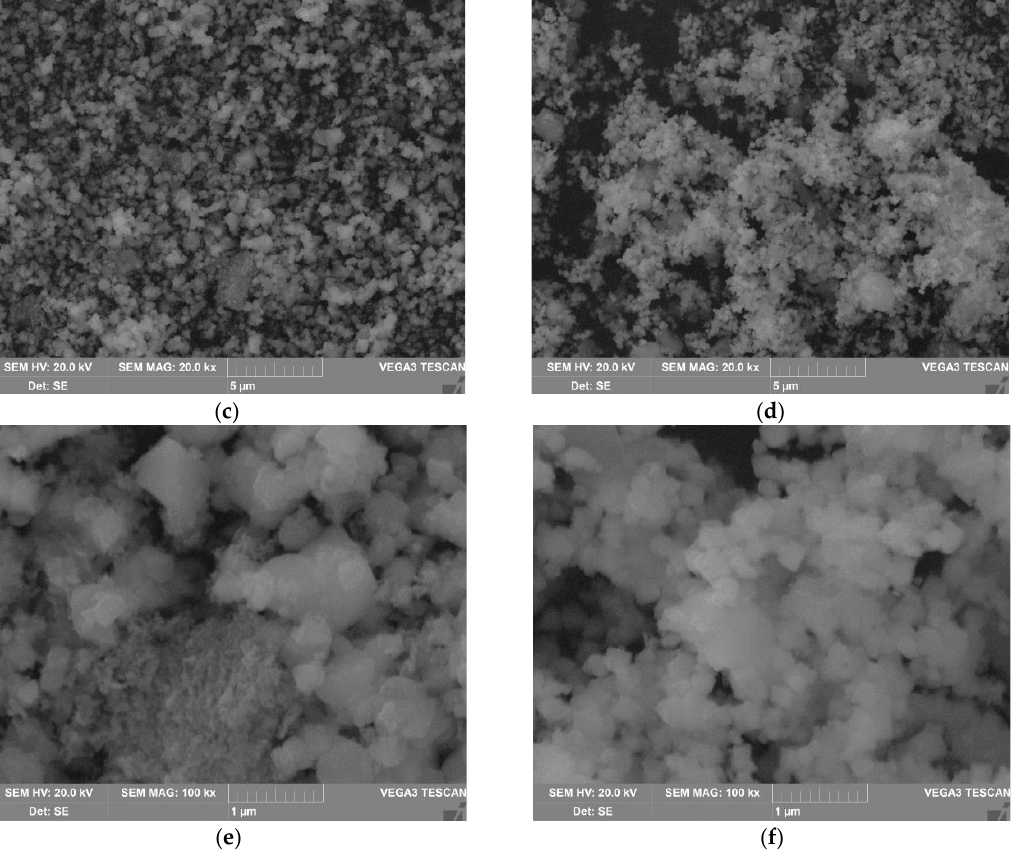
Figure 9. Mapping and morphology of the surfaces of BR and sand residues using SEM-EDX analysis: BSE image and mapping of the BR residue surface ( a ); BSE image and mapping of the sand residue surface ( b ); SEM image of the BR residue surface at 20 kx magnitude ( c ); SEM image of the sand residue surface at 20 kx magnitude ( d ); SEM image of the BR residue surface at 100 kx magnitude ( e ); SEM image of the sand residue surface at 100 kx magnitude ( f ).